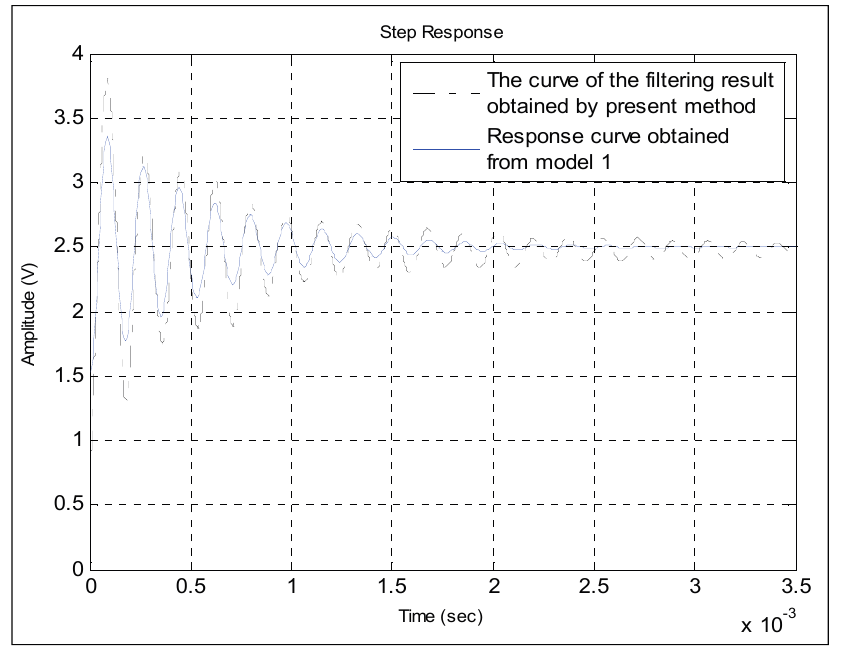
Figure 9. Comparison between the step response obtained from Model 1 and the curve of the filtering result obtained by the presented